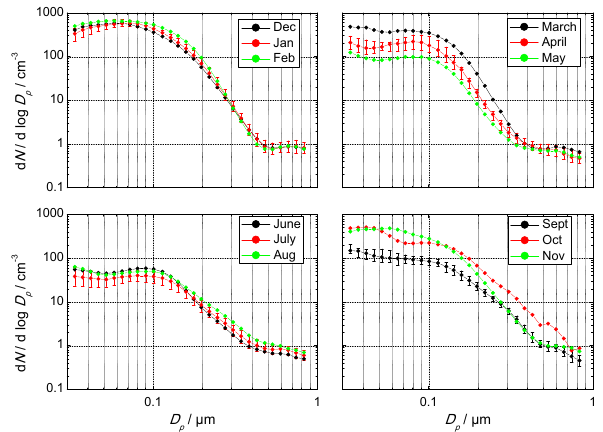
Fig. 8. Monthly average particle number size distributions (PNSDs) based on the 2007–2011 data measured at Troll for all baseline air masses as determined by the aerosol scattering coefficient criterion described in the text. The PNSDsare grouped by season in panels; summer top left, autumn to right, winter bottom left, spring bottom right. The 25th and 75th percentiles are plotted as whiskers to indicate the atmospheric variability.